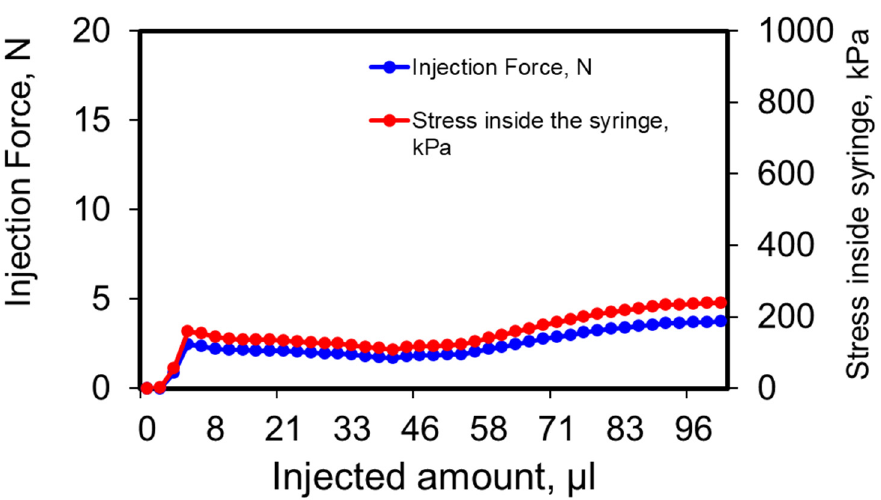
Figure 3. Injection Force and pressure on syringes filled with pramlintide-silica sol-gel system. A 25 G needle was attached to the plunger, and the plunger was pushed at 60